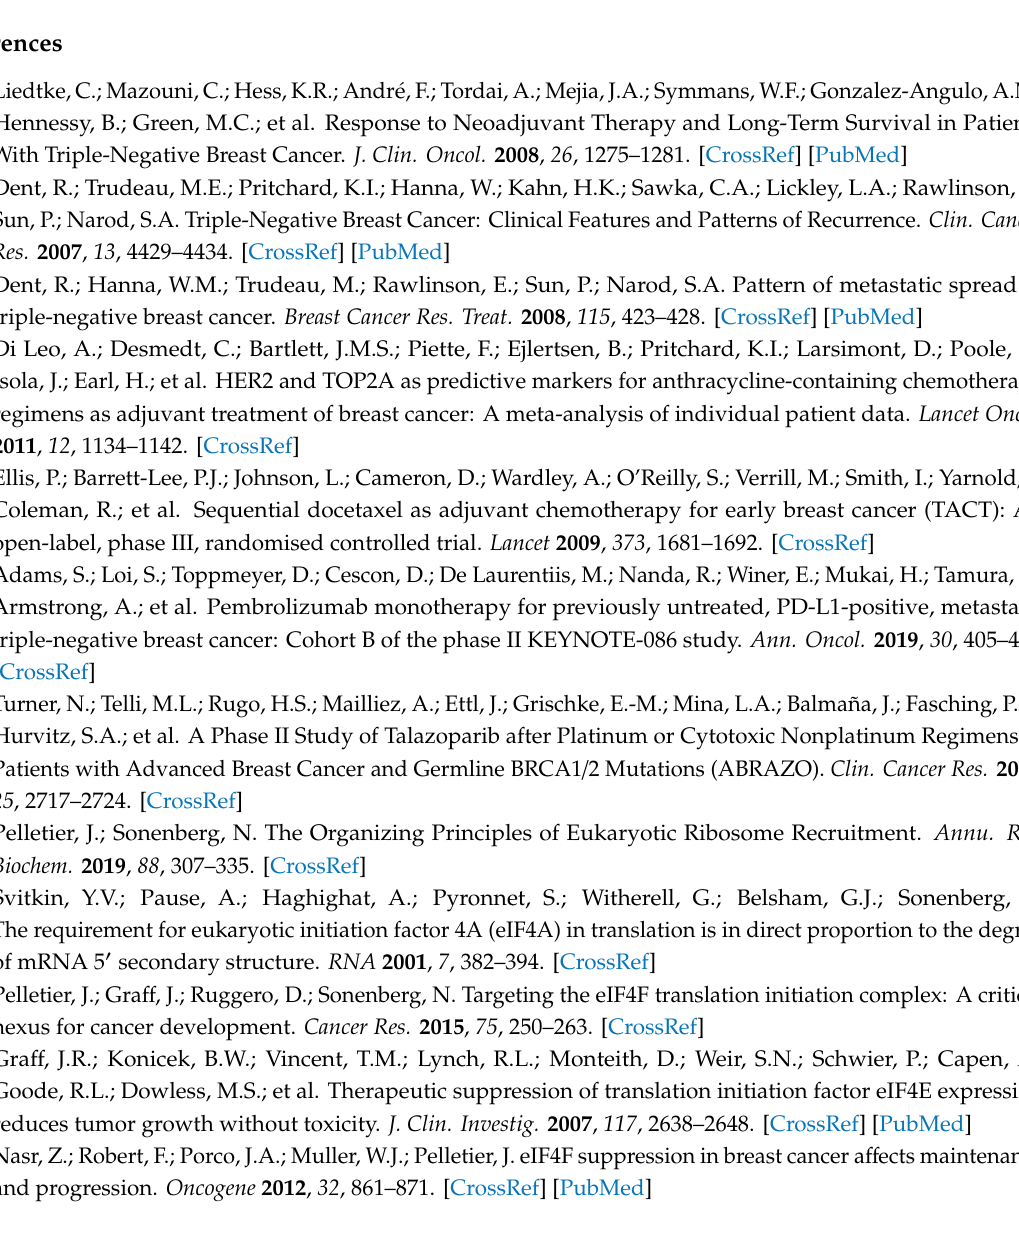
Figure S1: Cardiac glycosides modulate eIF4A expression levels through c-MYC; Figure S2: Uncropped blot